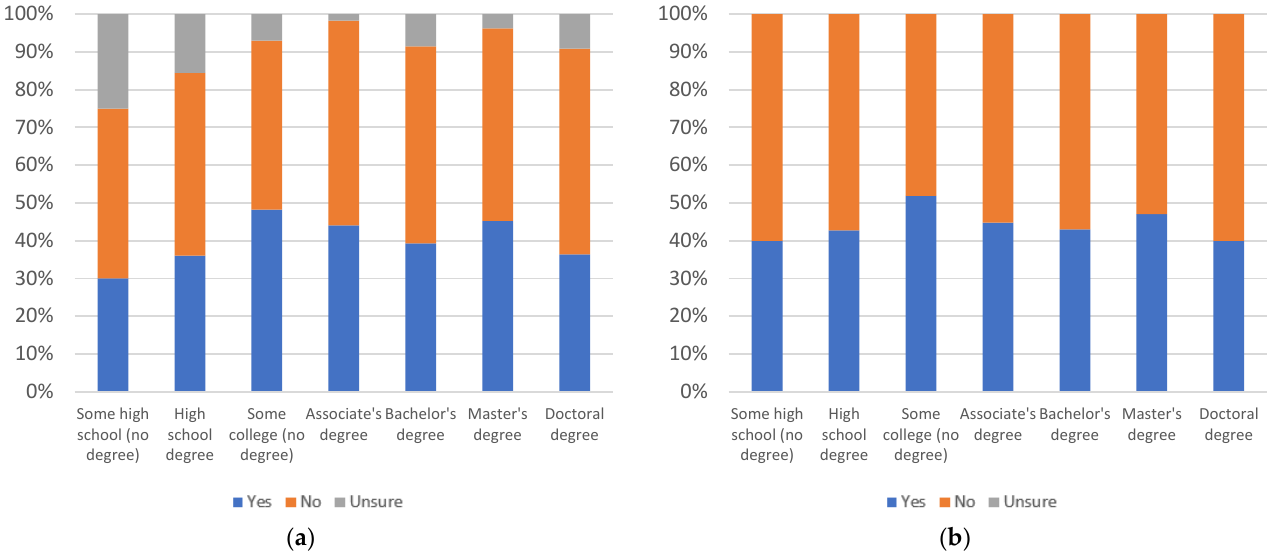
Figure 89. Label annoyingness, by education level: ( a ) with uncertain respondents (left) and ( b ) without uncertain respondents (right).